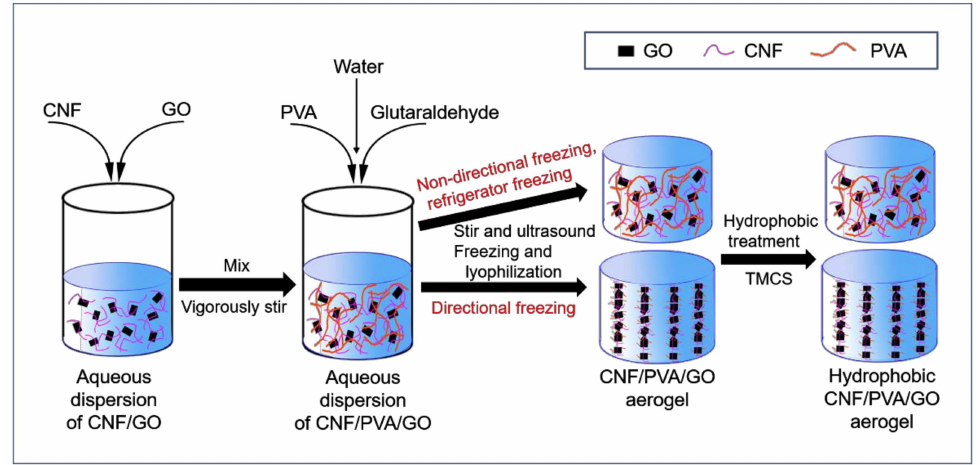
Figure 2. Schematic showing experimental process of the